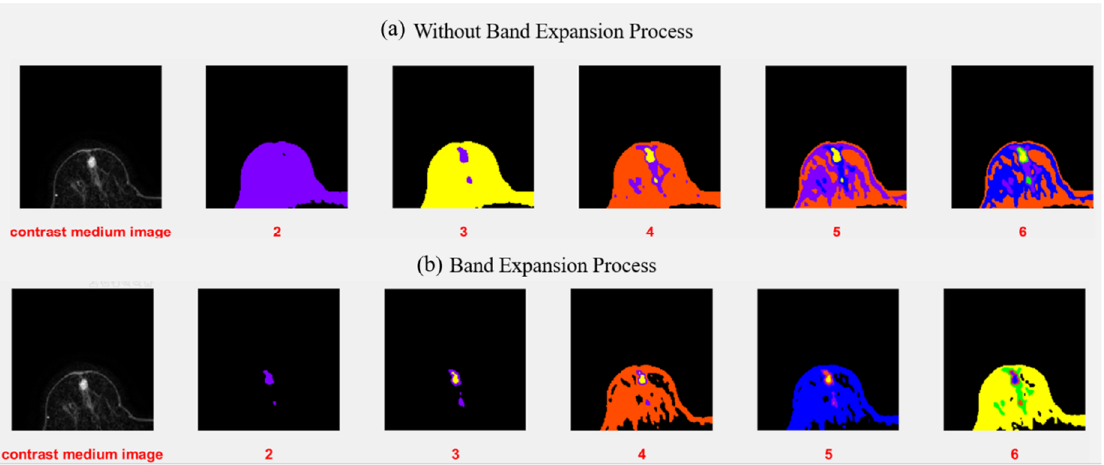
Figure 8. K-means results when k = 2–6: ( a ) images without band expansion process; ( b ) images after band expansion process.